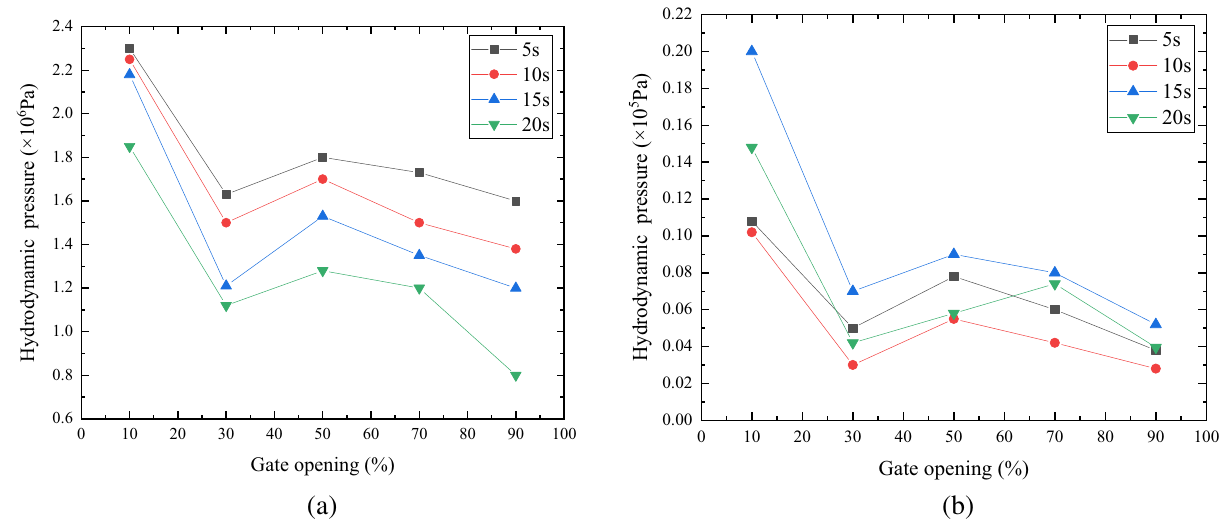
Figure 6. Distribution of hydrodynamic pressure on the surface of radial gate ( a ) Maximum hydrodynamic pressure with different opening, ( b ) Minimum hydrodynamic pressure with different opening.